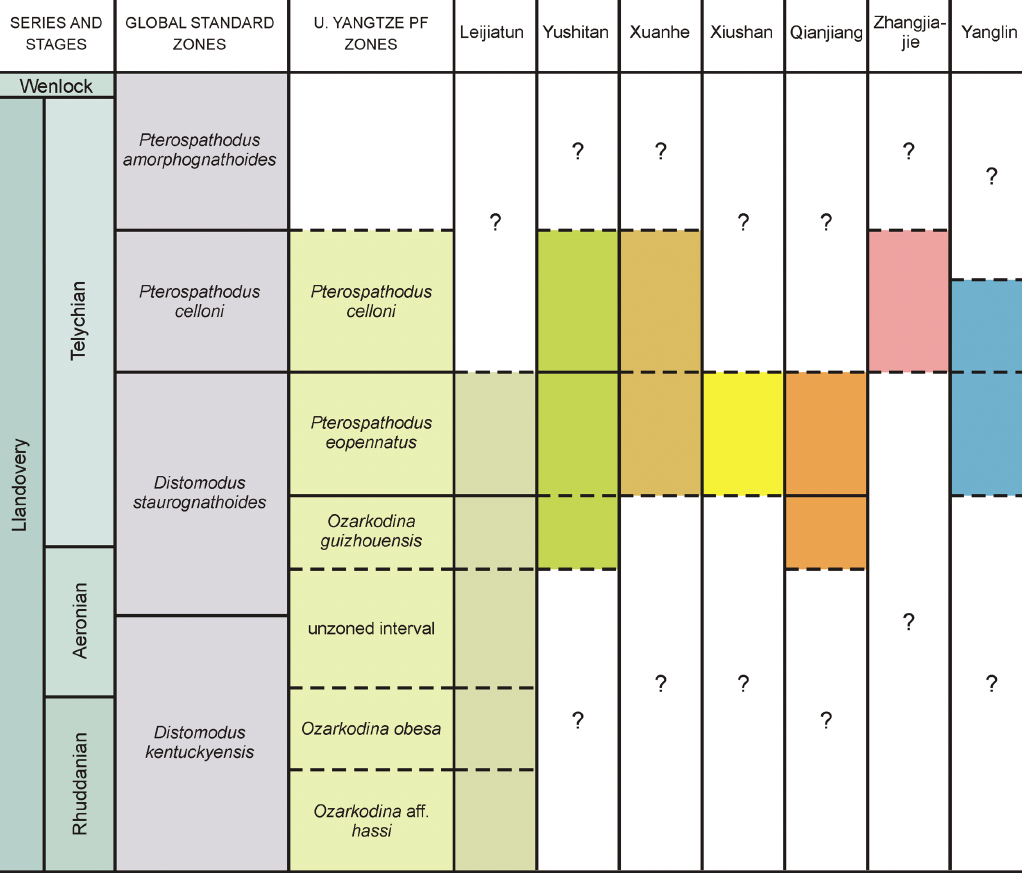
Fig. 2. Conodont biozonation for the Llandovery Series. The Global Standard biozonation comes from Aldridge & Sch(cid:246)nlaub (1989). The conodont biozonation of the Upper Yangtze Platform (U. Yangtze PF) comes from Wang & Aldridge